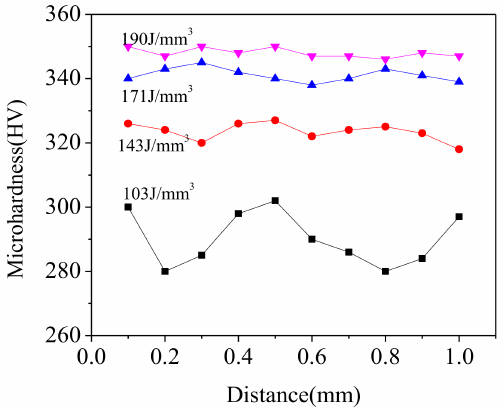
Figure 12. Hardness distribution of SLM as-built samples at different